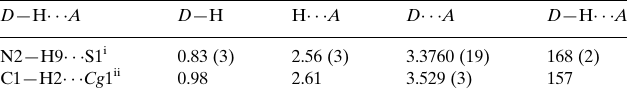
Hydrogen-bond geometry (A˚ , (cid:3) ). Cg 1 is the centroid of the C1–C6